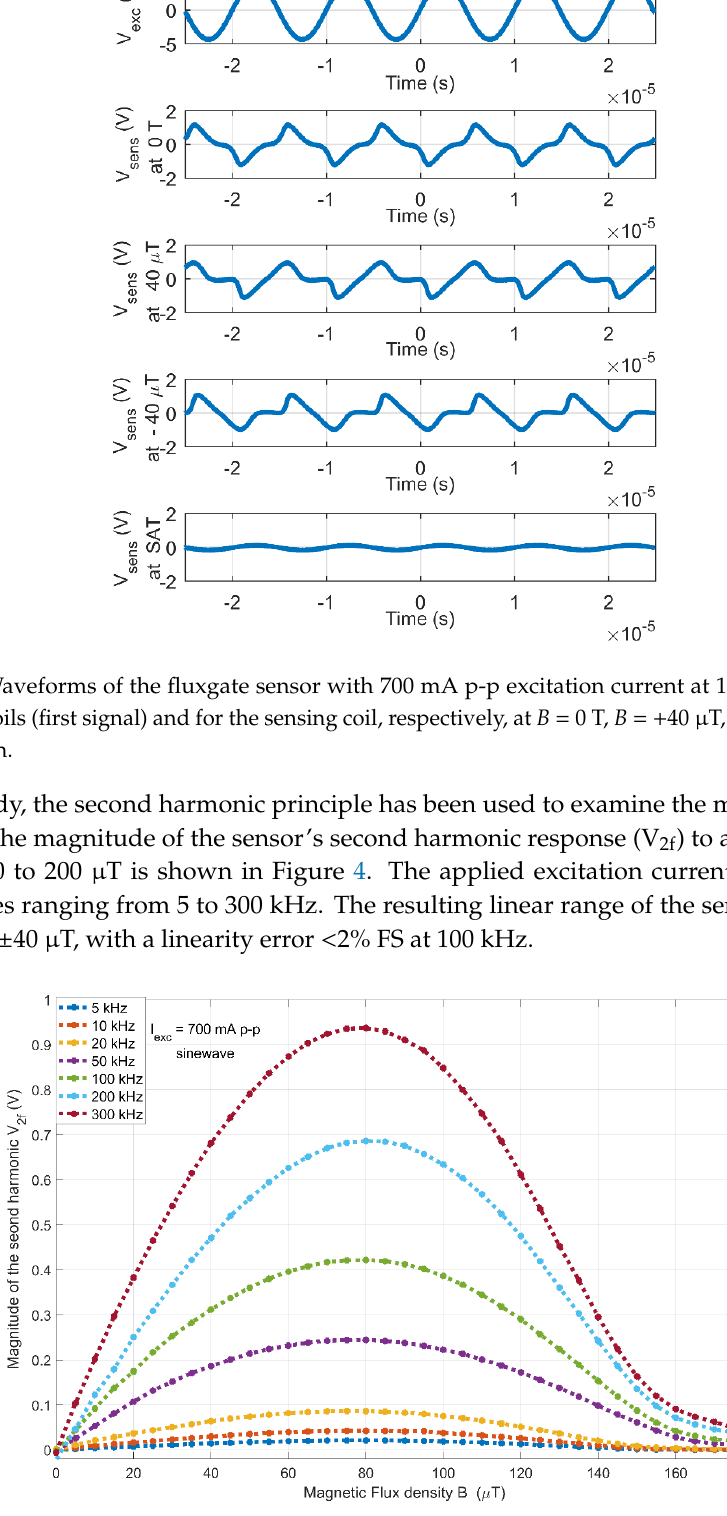
Figure 4. Magnitude of the sensor’s second harmonic response to the applied magnetic field at 700 mA p-p for 5–300 kHz excitation frequency range. p-p for 5–300 kHz excitation frequency